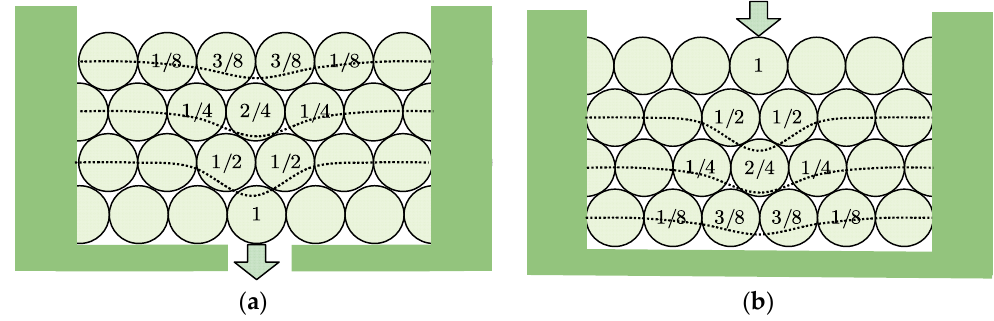
Figure 7. The schematic diagram of ( a ) excavation and ( b ) dynamic compaction.